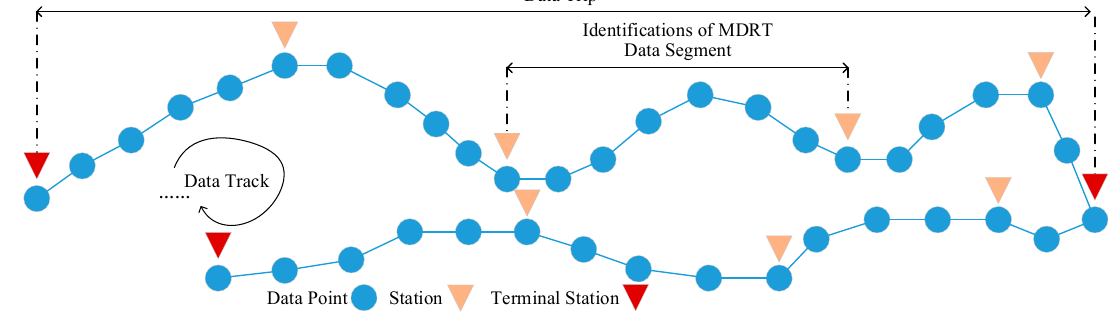
Figure 3. Illustration of Representation of Trajectory Data.